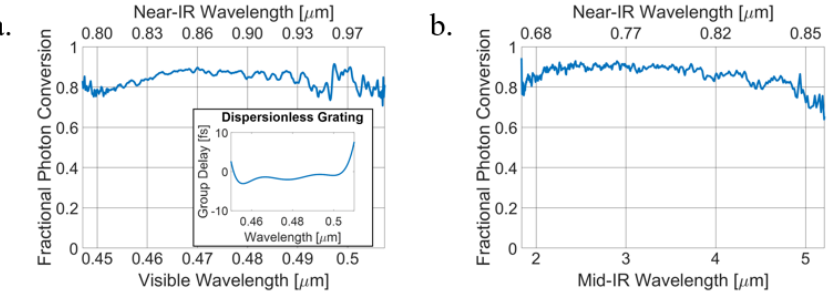
Fig. 2. Fractional photon conversion of adiabatic sum (a) and difference (b) frequency generation stages measured by the fractional depletion of the near-IR power spectrum. Inset shows simulated group delay of the ASFG